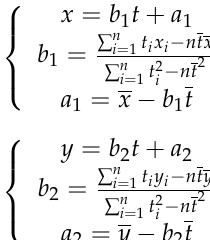
Figure 18. Flow chart for judging whether there is a foreign object directly below.